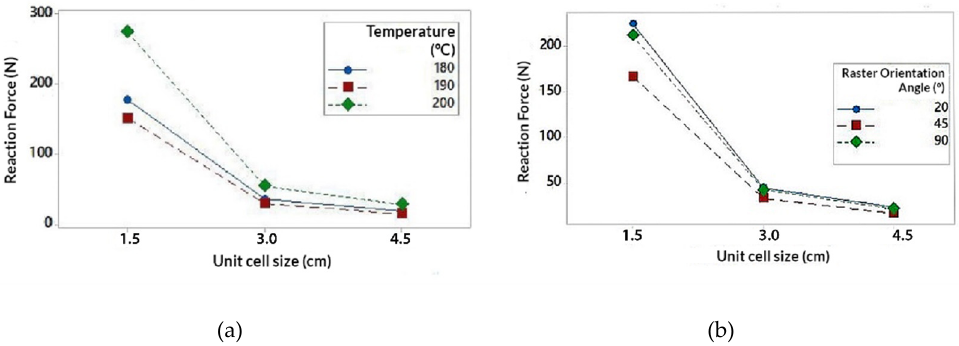
Figure 6. Interaction graph on unit size (U); ( a ) Unit size (U) in relation to temperature (T); ( b ) Unit size (T) in relation to the orientation angle (R).